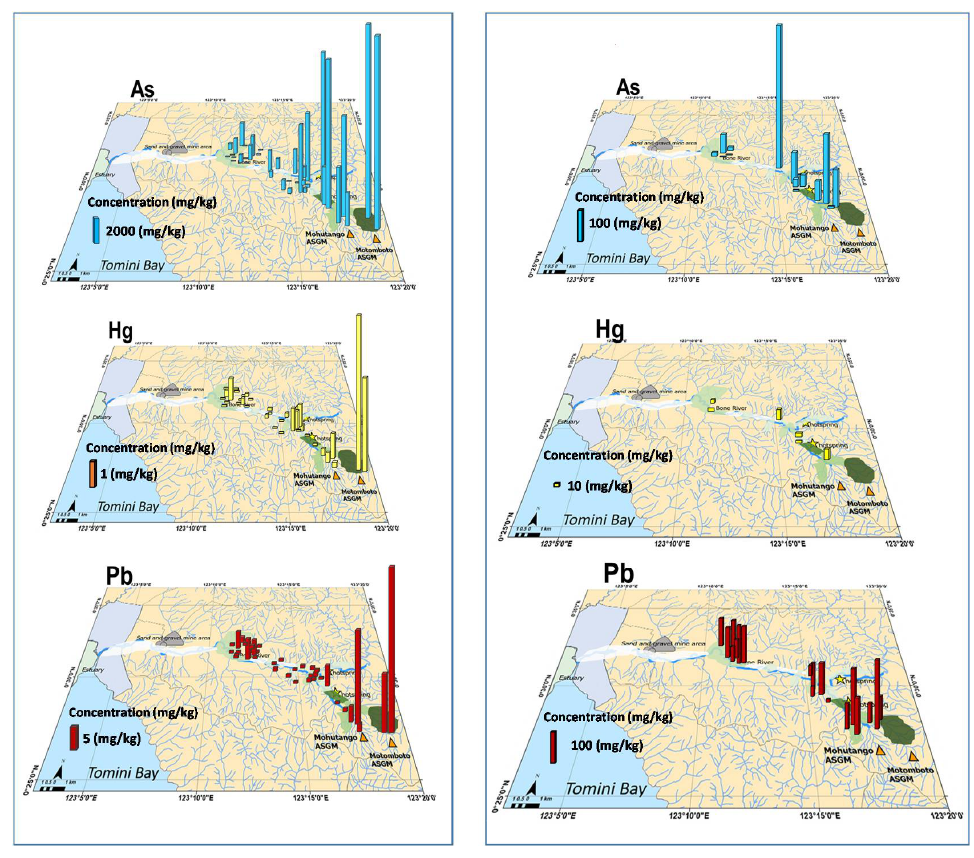
Figure 5. As, Hg, and Pb concentrations in P. vittata ( left ) and soil ( right ) samples were taken along the Bone River (mg kg −1 ). Table 1. Concentrations of As, Hg, and Pb in the soil samples along the Bone River.